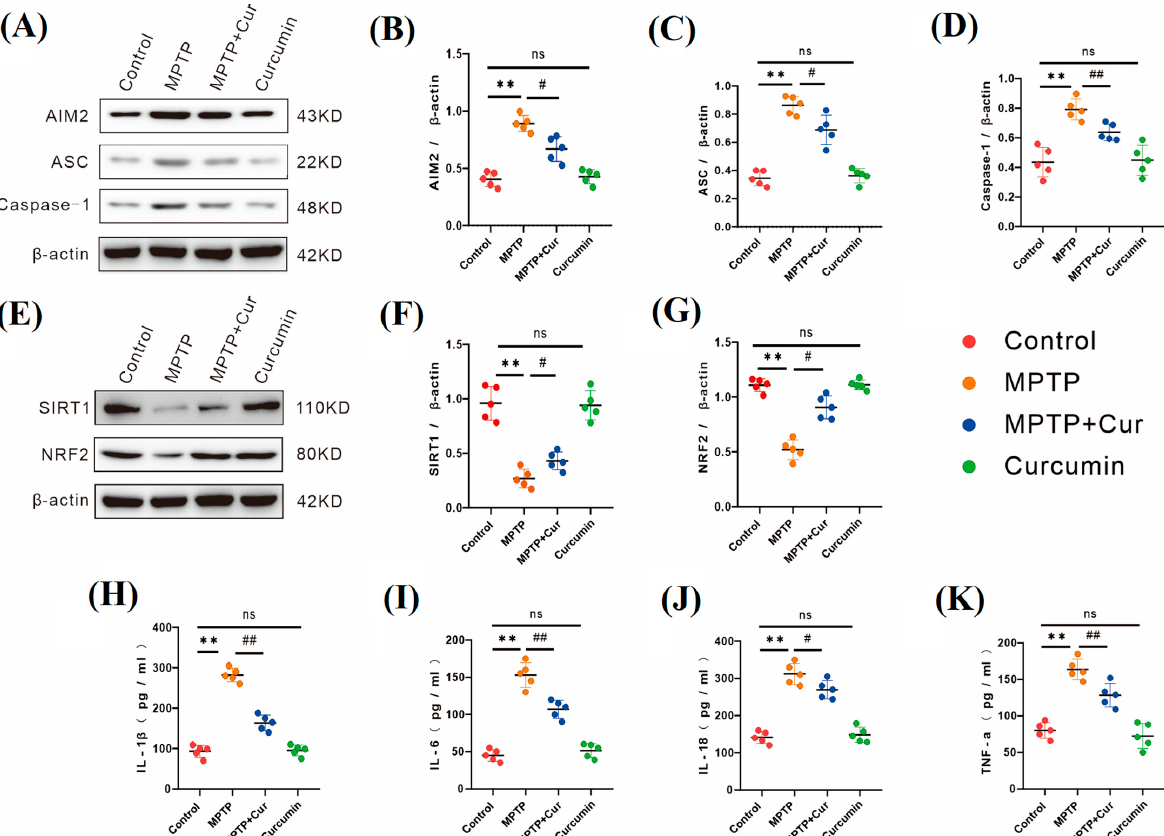
Figure 5. Curcumin ameliorated the inhibition of pyroptosis to attenuate intestinal inflammation and activation of the SIRT1/NRF2 pathway in MPTP-induced model mice. ( A ) Western blot was used to detect AIM2, ASC, and caspase-1 proteins in the four groups of cecum tissues ( n = 5); ( B – D ) analysis of AIM2, ASC, and caspase-1 protein expression in cecum tissues ( n = 5); ( E ) detection of SIRT1 and NRF2 proteins in the four groups of cecum tissue by Western blot ( n = 5); ( F , G ) analysis of SIRT1 and NRF2 protein expression in cecum tissue ( n = 5); AIM2, ASC, caspase-1, SIRT1, and NRF2 protein expressions were quantified using ImageJ; ( H – K ) the expression levels of pro-inflam- matory factors IL-1 β , IL-6, IL-18, and TNF- α in intestinal tissue homogenates were analyzed using ELISA ( n = 5). All statistical differences were tested using the t -test ( B – D , F – K ). Data are expressed as the mean ± SEM ( n = 5/group), with representative results for one of the independent experiments. ** p < 0.01 vs. control group. # p < 0.05 and ## p < 0.01 vs. MPTP group. n.s., not significant.